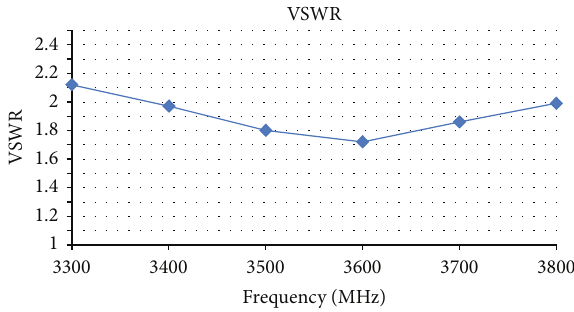
Figure 11: VSWR variation for the circular SPA with two active elements.